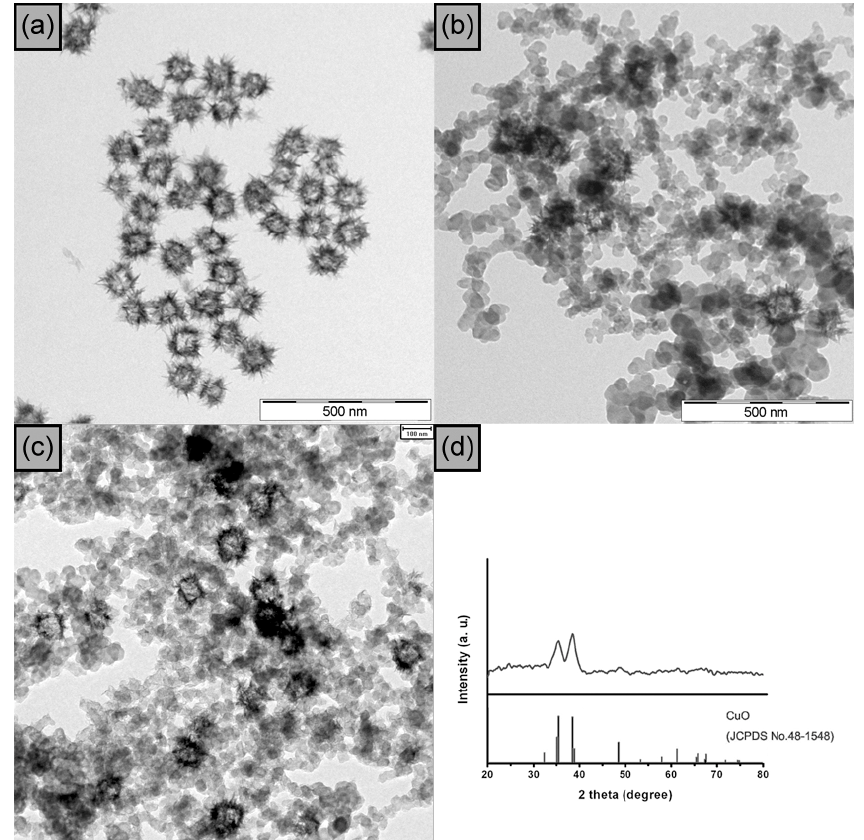
Figure 2. TEM images of ( a ) CuO hollow nanoparticles; ( b ) CuO hollow nanoparticles on acetylene black; and after fifth cycle ( c ); ( d ) XRD spectra of CuO hollow nanoparticles